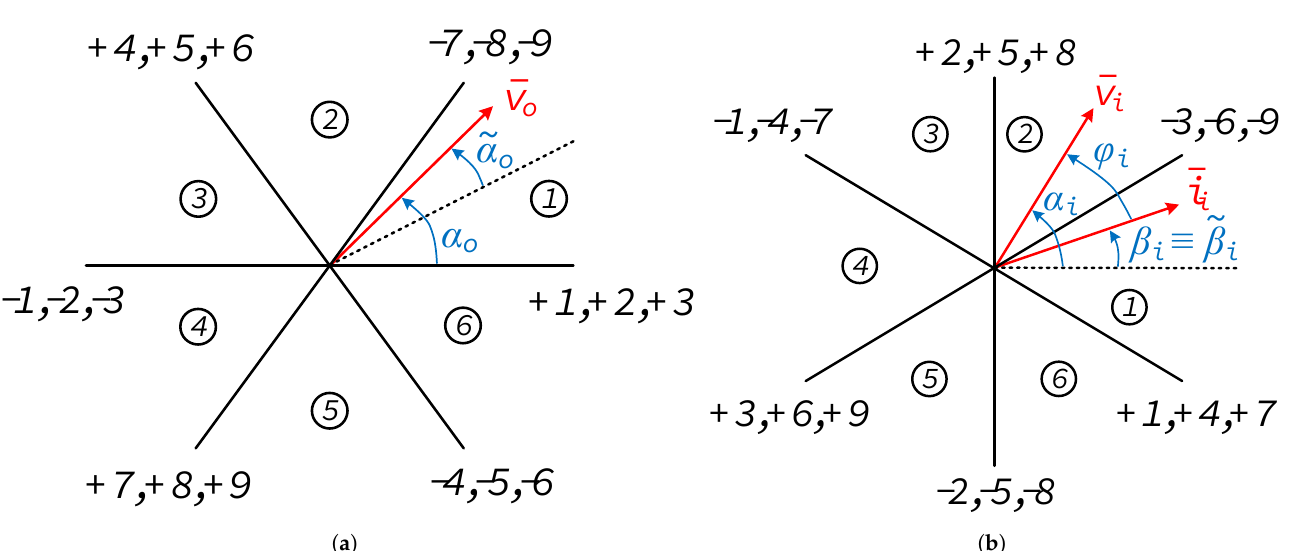
Figure 6. Stationary vectors representation in αβ frame. ( a ) Output voltage SSVs. ( b ) Input current